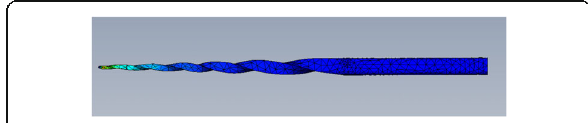
Fig. 4 Finite element model of the file